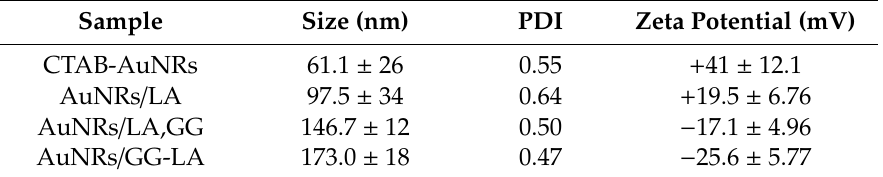
Table 3. Dynamic light scattering measurements. Hydrodynamic diameters (numeric), polydispersity index (PDI) and ζ potentials of hexadecyltrimethylammonium bromide (CTAB)-AuNRs, AuNRs / LA, AuNRs / LA,GG, and AuNRs /